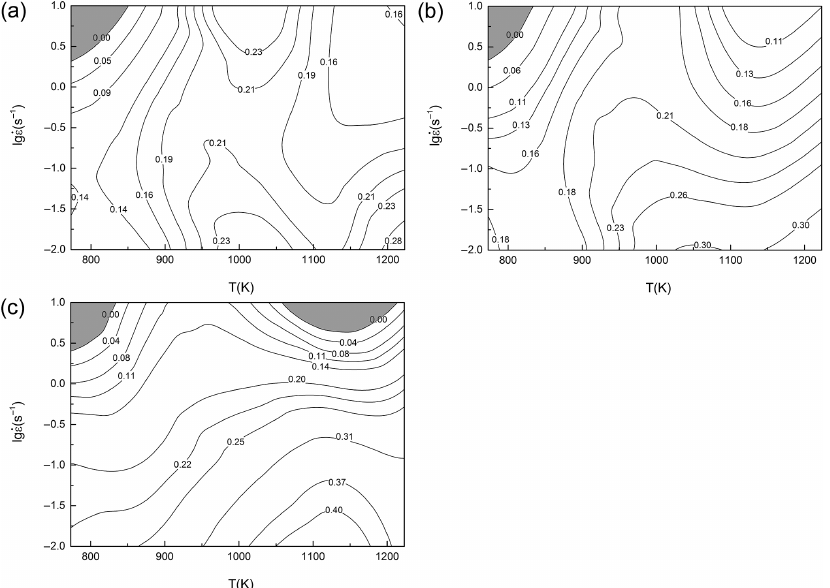
Figure 7: The power dissipation maps of ultra-high strength steel BR1500HS at different strain value: (a) ε = 0.05, (b) ε = 0.10, (c) ε =